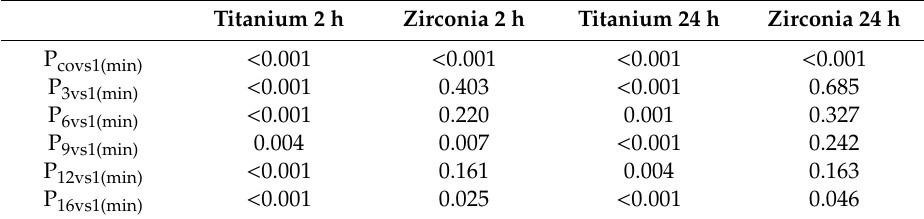
Table 3. Statistical results of one-way analysis of variance test in 1 min oxygen nonthermal plasma treated groups.